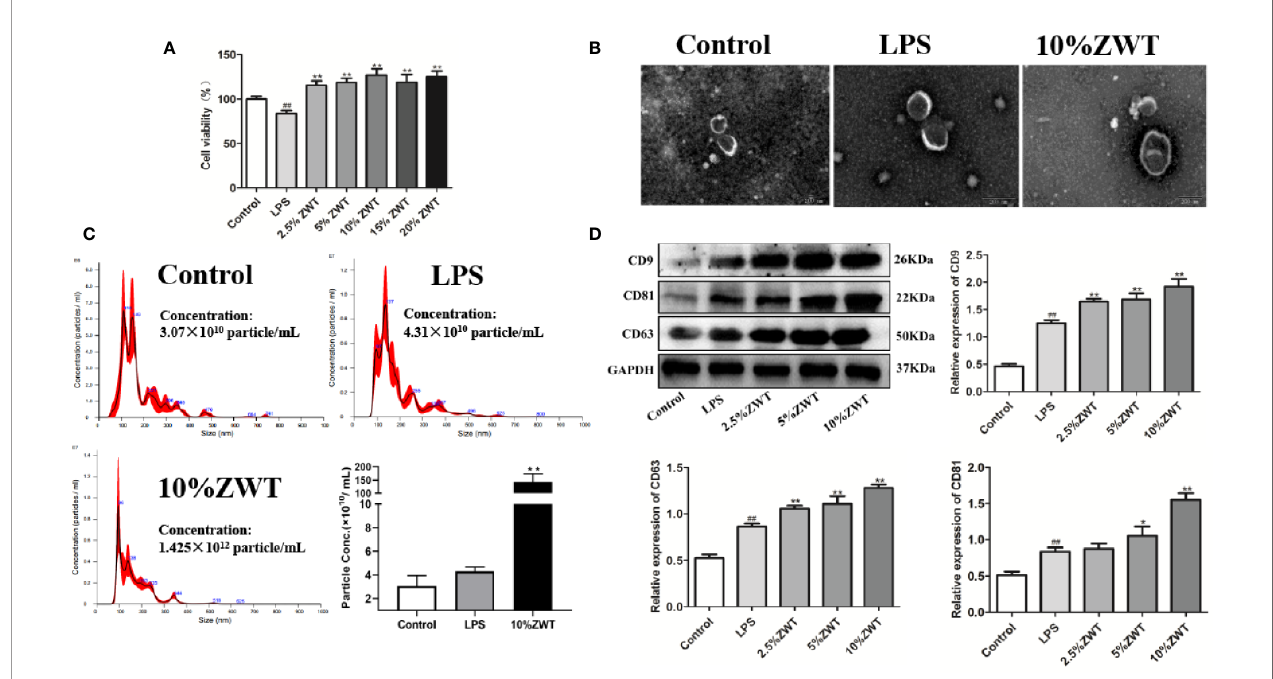
FIGURE 2 | The characterization of exosomes and intervention of Zhen-wu-tang (ZWT). HK-2 cells were subjected to lipopolysaccharide (LPS) (100 ng/ml) and treated with or without ZWTS (2.5%, 5%, 10%, 15%, and 20%) for 24 h. (A) Cell vitality of HK-2 cells was examined by MTT assay. (n = 6). (B) Exosomes derived from HK-2 cells were identi fi ed by transmission electron microscopy (TEM). Magni fi cation: ×15,000. Scale bar: 200 nm. (n = 3). (C) Size distribution of exosomes extracted from HK-2 cells conditioned medium by nanoparticle analysis (NTA). (n = 3). (D) Exosomal marker proteins including CD9, CD81, and CD63 in the supernatant of HK-2 cells were determined by western blot. (n = 3). The statistical data of all the proteins were analyzed and transformed by ImageJ 1.8.0 112 software. All values were shown as mean ± SD. # P < 0.05, ## P < 0.01, compared with control group; *P < 0.05, **P < 0.01, compared with LPS